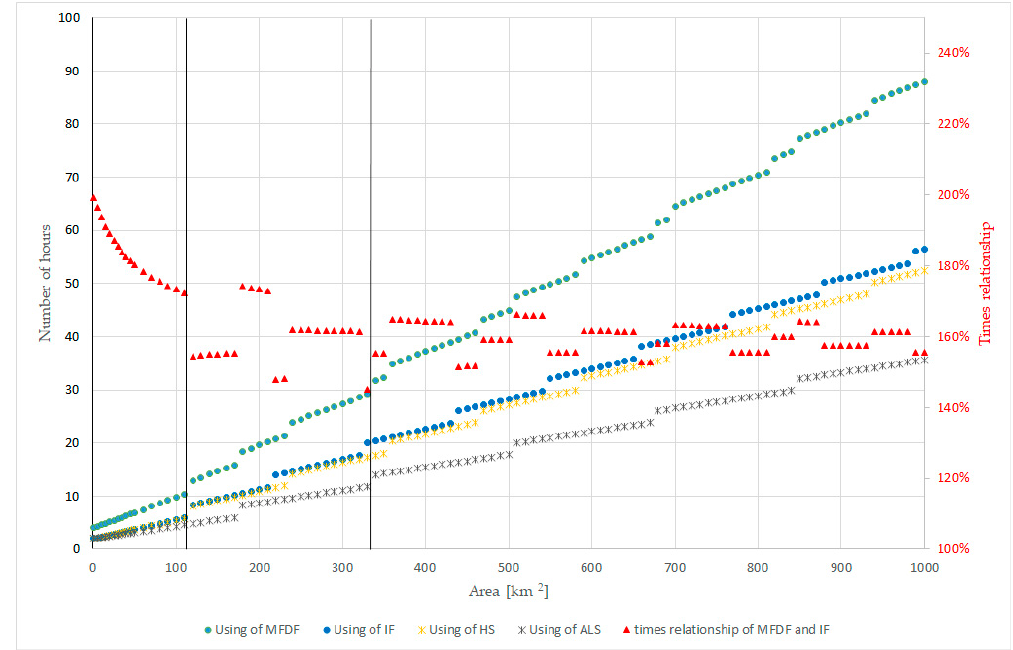
Figure 3. Number of hours using MFDF, IF, hyperspectral scanners, LiDAR scanner, and the time relationship of MFDF against IF data collection for flyover surface areas ranging from 1 to 1000 square kilometers. Abbreviations: HS—Hyperspectral images; ALS—Airborne Laser Scanning; MFDF—Multiple Flights Data Fusion; IF—Instrument Fusion.